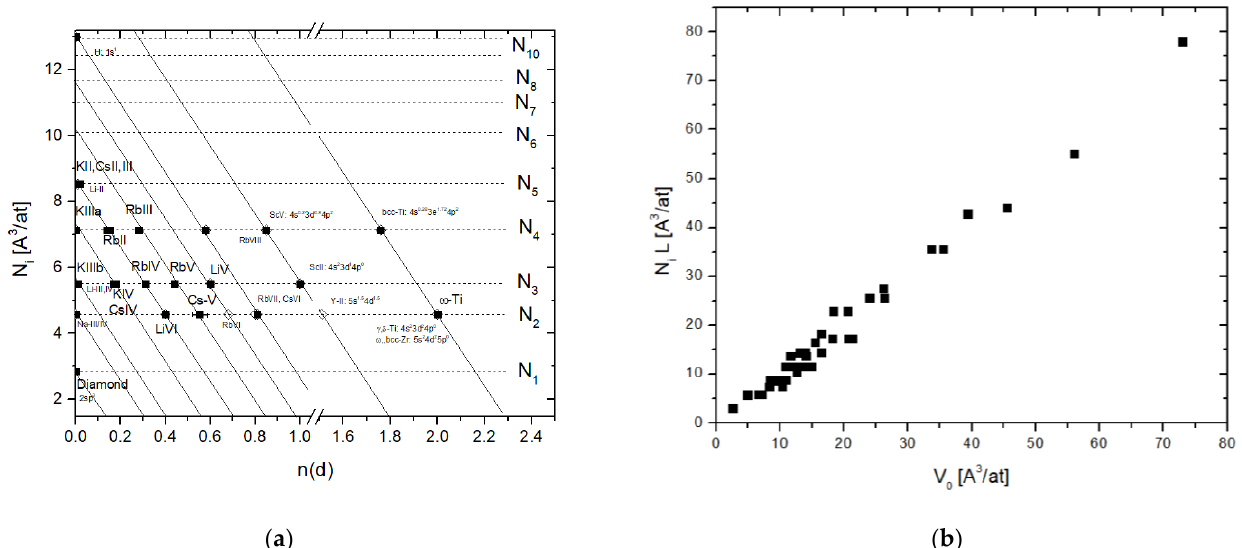
Figure 3. ( a ) Correlation between the normalized transformation volumes V tr from Equation (1) and d-state occupancy. The volumes N i from Equation (1) were used to define the V tr /L sets of the alkaline metals [10] and of a selection of other elements as a function of d-state occupancy. Filled symbols: measured d-state occupancies; hollow symbols: estimated occupancies based on Equations (1) and (2). Solid lines: fitted correlation for KII, Rb-II and -IV, and Cs-II and -III. The same slope has then been applied to all data. Dashed lines give the values N i and are guides for the eye. ( b ) Comparison of the atomic volumes of elemental non-molecular solids at ambient pressure and temperature with the calculated volumes N i ·L. The correlation is linear with an adjusted R 2 = 0.9928 and a slope of 1.015(13), which reflects a general slight contraction of the elemental volumes relative to N i ·L.